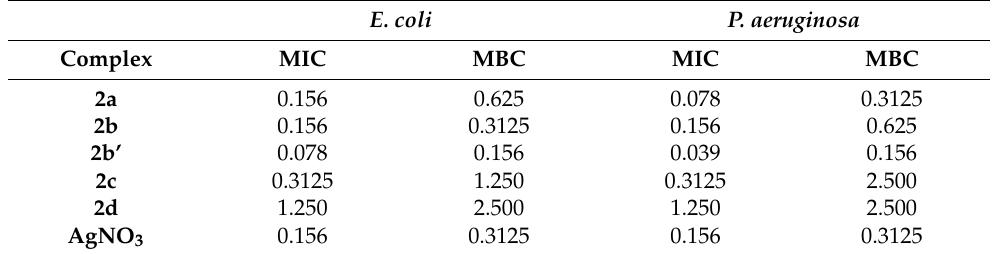
Table 1. Antimicrobial activities of the 2 complexes and AgNO 3 evaluated by MIC and MBC (mM). E. coli